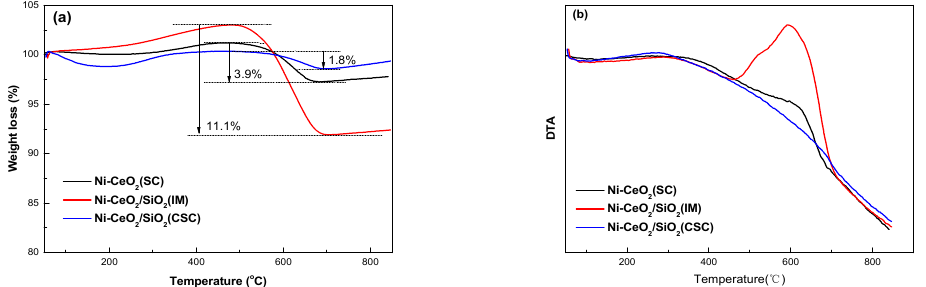
Figure 10. Characterizations of thermogravimetry (TG) (a) and differential thermal (DTA) (b) of the used catalysts.